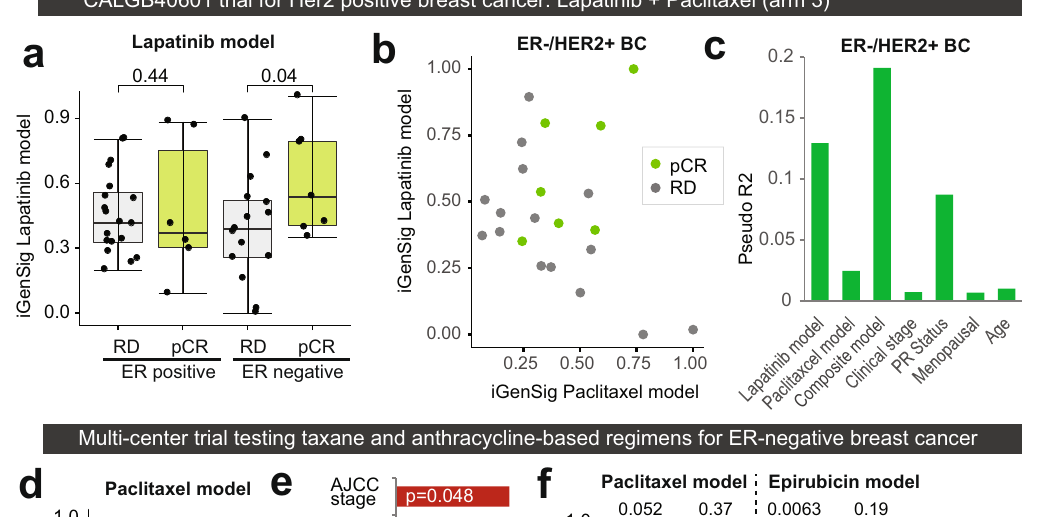
Multi-center trial testing taxane and anthracycline-based regimens for ER-negative breast cancer